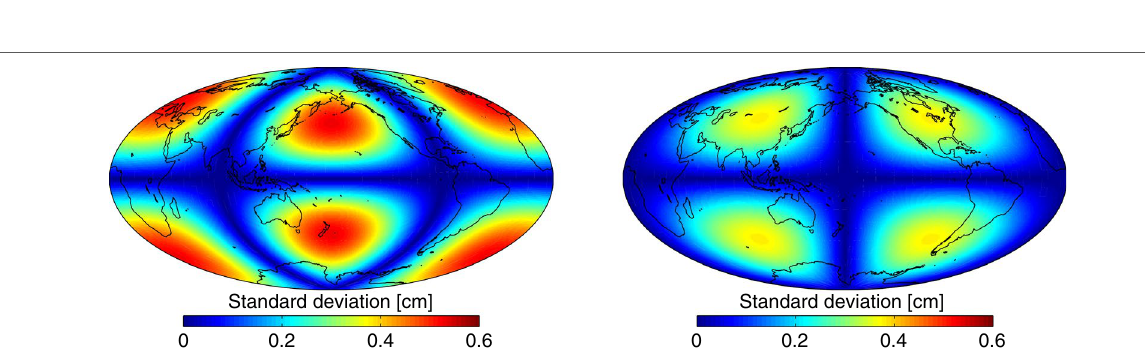
Fig. 7 Standard deviations of equivalent water height differences between the two CSR solutions (RL05 DDK2–RL06 DDK2) using only the potential coefficients C 21 (left) and S 21 (right) over 13 years